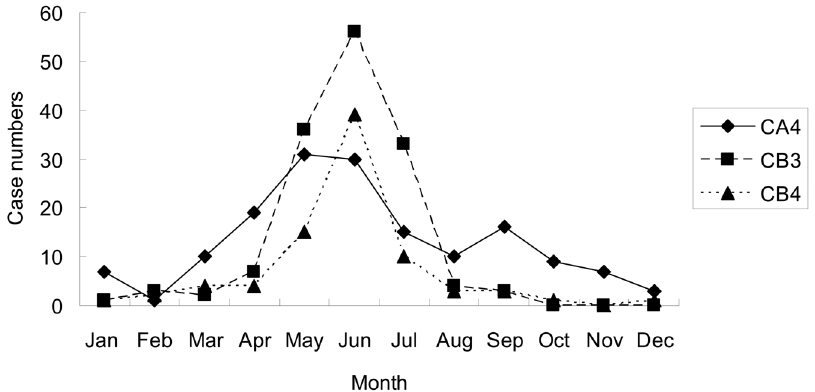
Figure 3. Monthly distribution of coxsackievirus A4 (CA4), B3 (CB3) and B4 (CB4) isolates from January, 2004 to June, 2012 in Chang Gung Memorial Hospital, Taiwan.